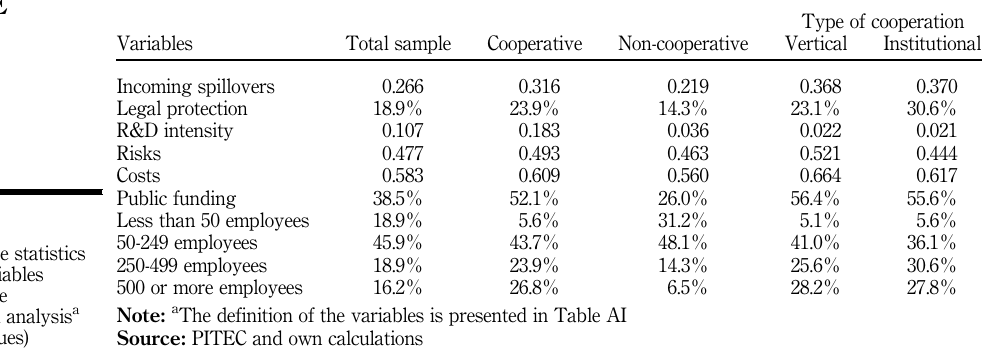
of the variables used in the regression analysis a (mean